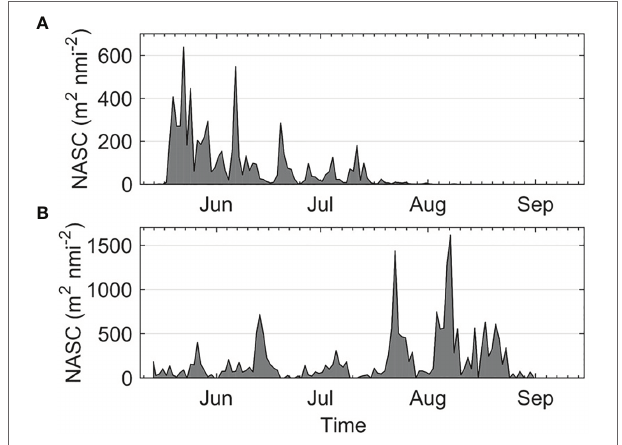
FIGURE 4 | Nautical area backscattering coefficient (m 2 nmi -2 ) for juvenile salmon (A) and herring (B)